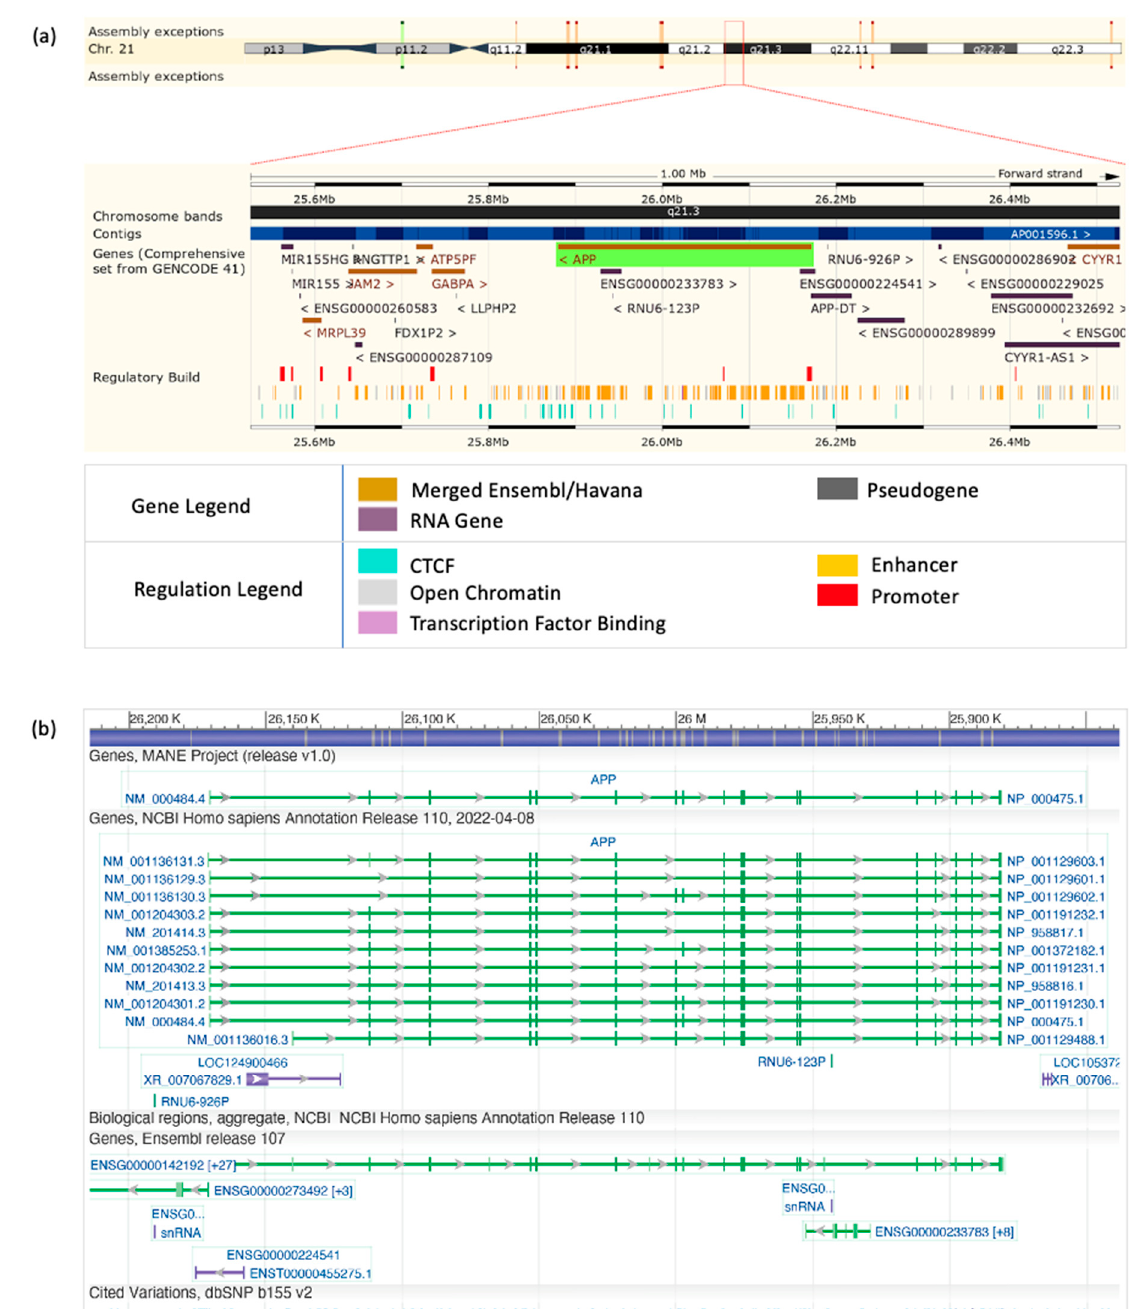
Figure 2. Visualizing APP gene information using ( a ) Ensembl genome browser 107 (July 2022, GRCh38) and ( b ) NCBI’s gene browser. GRCh38) and ( b ) NCBI’s gene